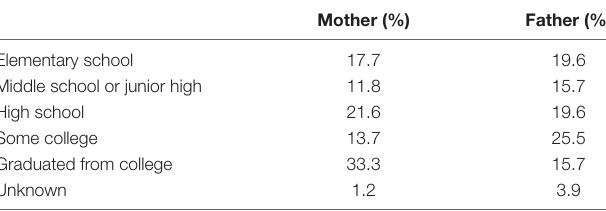
TABLE 2 | Highest level of education completed by participants’ parents.